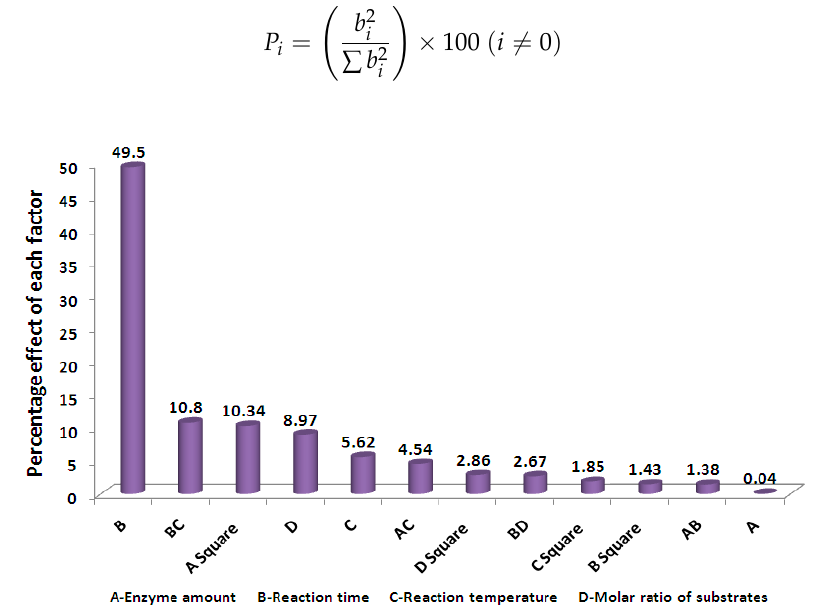
Figure 4. Pareto graphic analysis describes the effect of each of the variables (enzyme amount, reaction time, reaction temperature and molar ratio of substrates) in percentages (%).